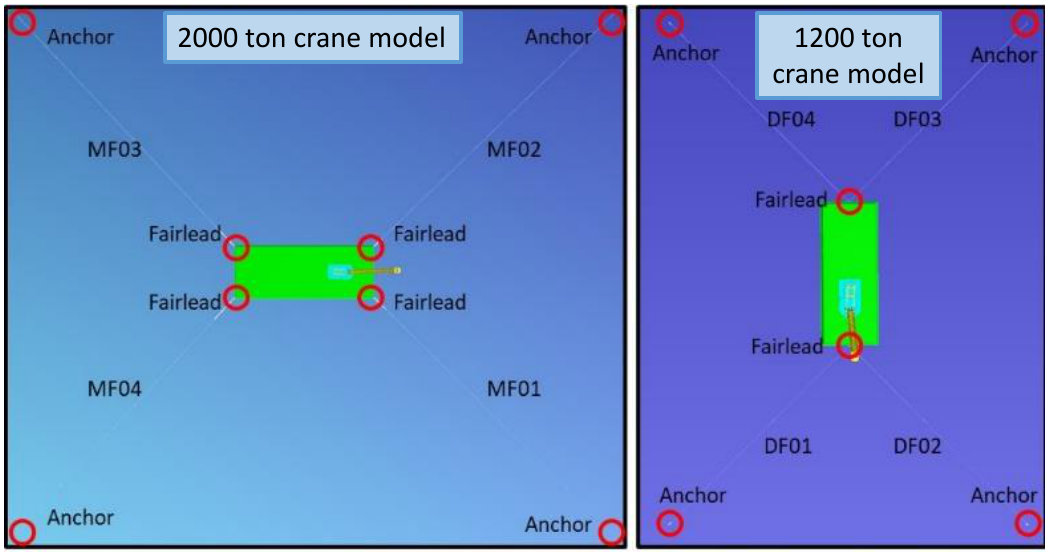
Figure 16. Mooring points of model test.